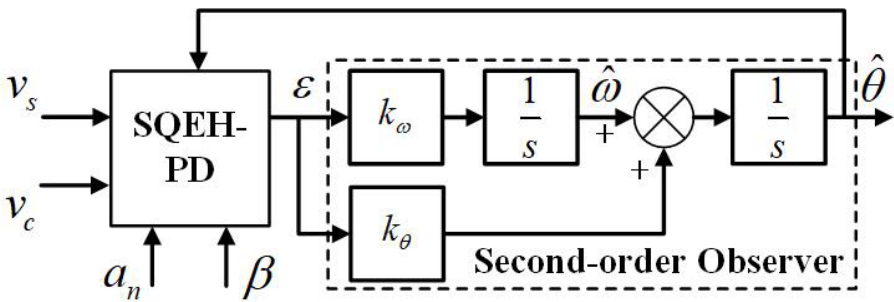
Figure 2. Schematic of the proposed DC-PLL.